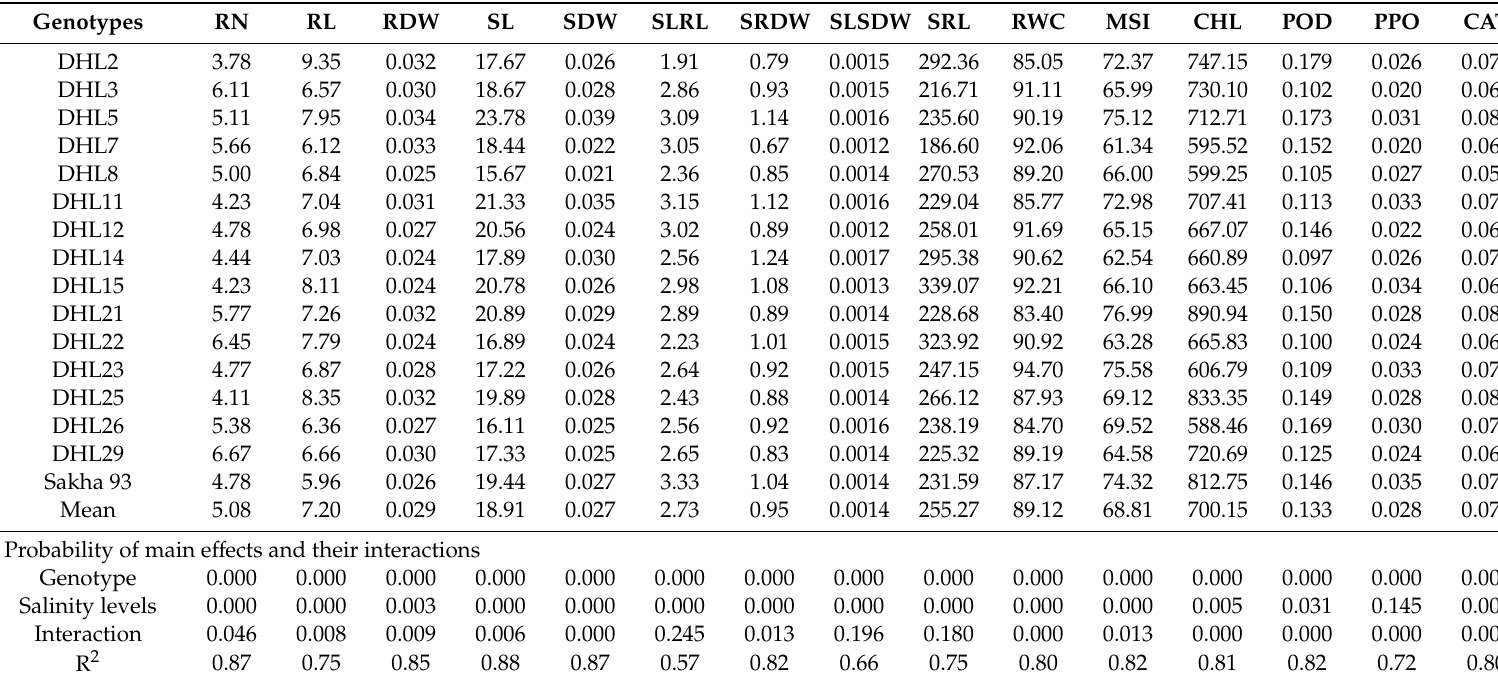
Table 2. Mean performance of wheat genotypes averaged across all salinity levels and the probability of main e ff ects and their interaction.